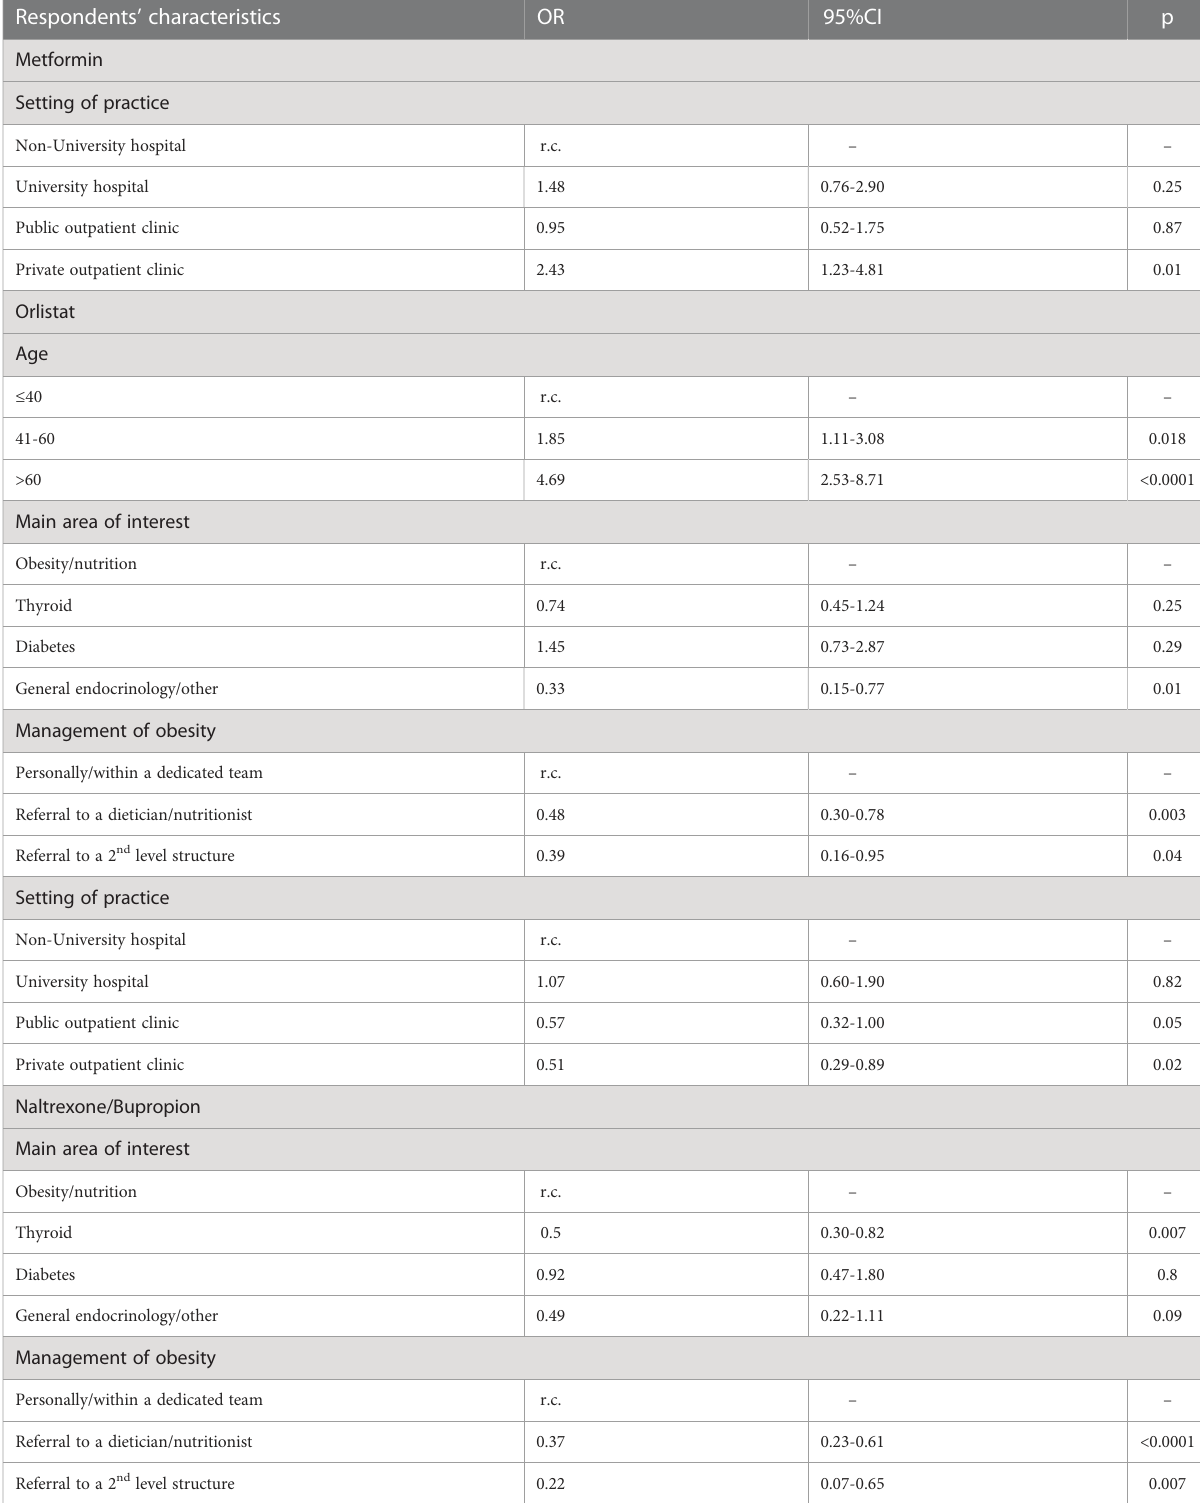
TABLE 7 Correlates of attitudes to prescribe anti-obesity drugs: results of multivariate analysis (logistic regression with stepwise variable